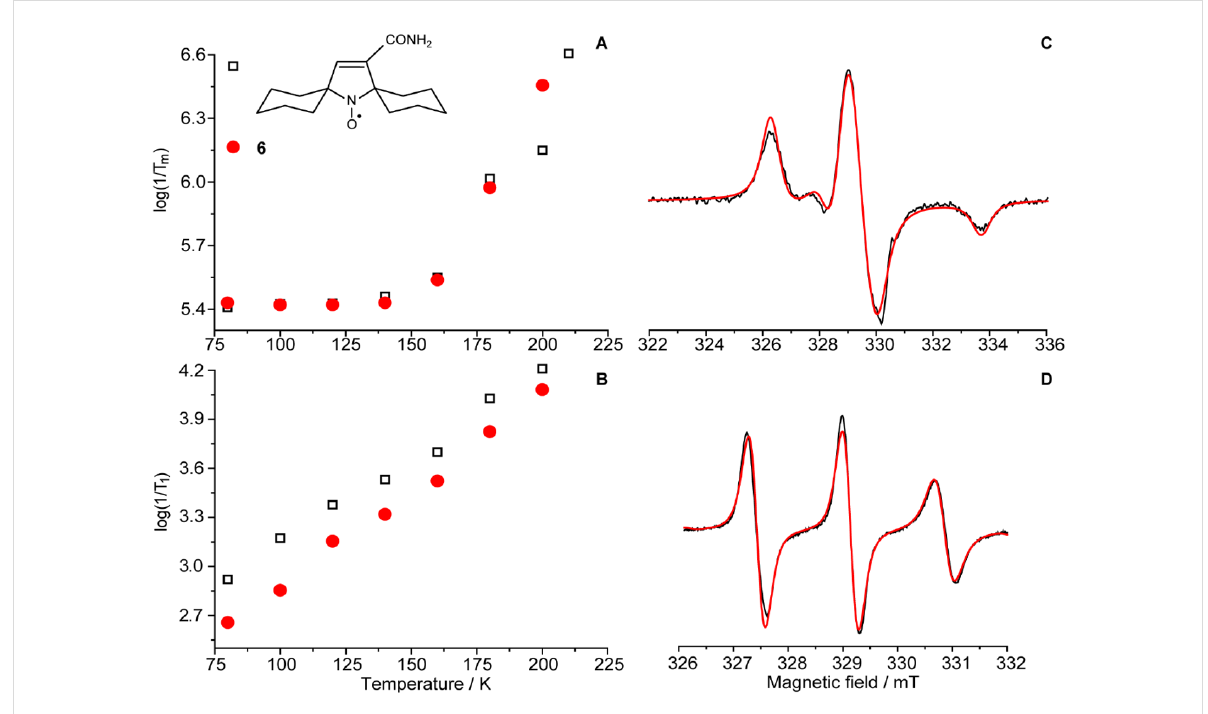
Figure 5: A, B) Temperature dependence of the electron spin relaxation times in water/glycerol at X-band frequency. The solid red dots are for nitroxide 6 ; the open black squares are for spirocyclohexane-substituted nitroxide. C, D) CW EPR spectra of nitroxide 6 at 180 K (C) and at room tem- perature (D) in water/glycerol. Black lines are experimental spectra and the red lines are simulations for hfi, g-factor and correlation times of A(N) = [0.71; 0.71; 3.71] mT, g = [2.0087; 2.0055; 2.0019], t corr = 0.53 ns (at 298